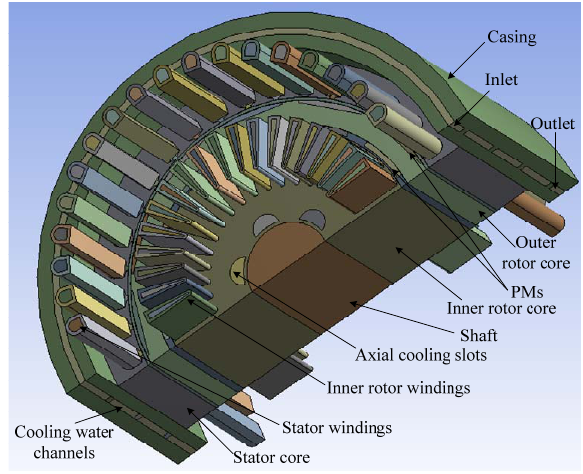
Figure 6. Three-dimensional (3-D) finite-element analysis (FEA) model of the CS-PMSM thermal